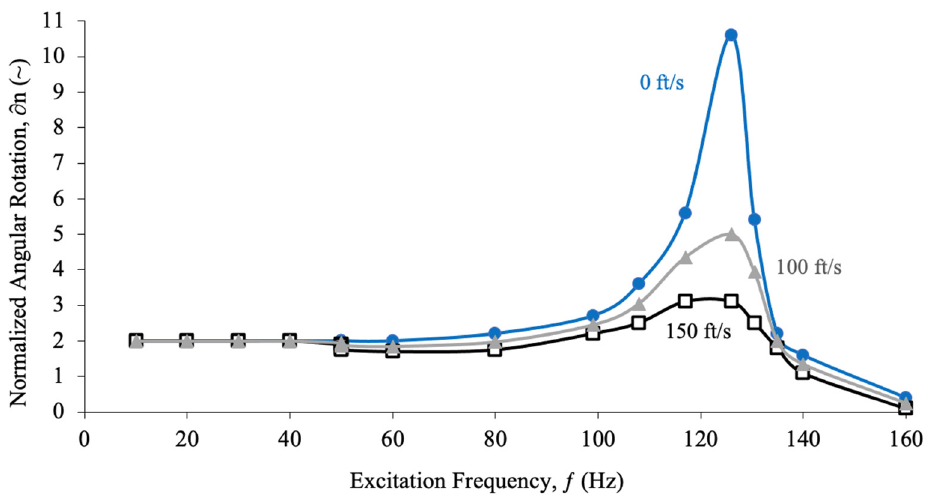
Figure 16. LDD Stabilator Deflection Decay with Increasing Airspeed.